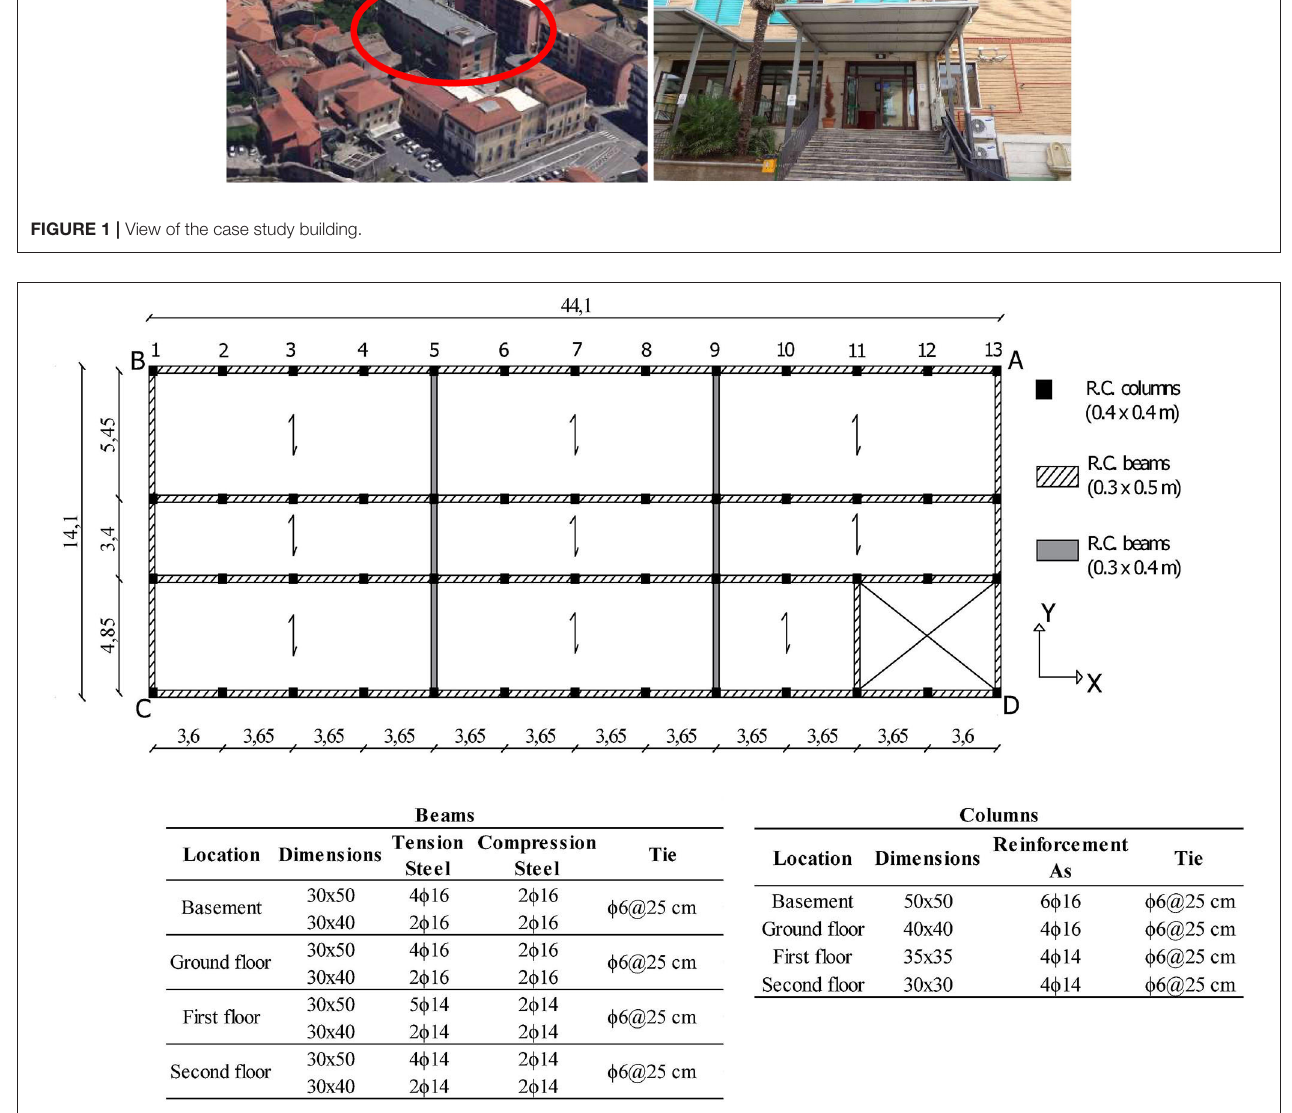
FIGURE 2 | Main geometrical and structural properties of the first level of the case study building.